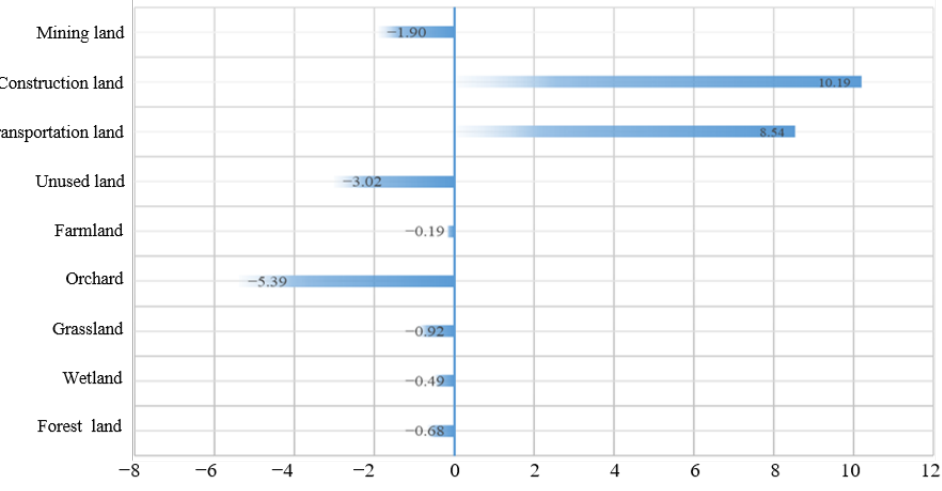
Figure 4. Percentage change of land-use type area from 2010 to 2017.